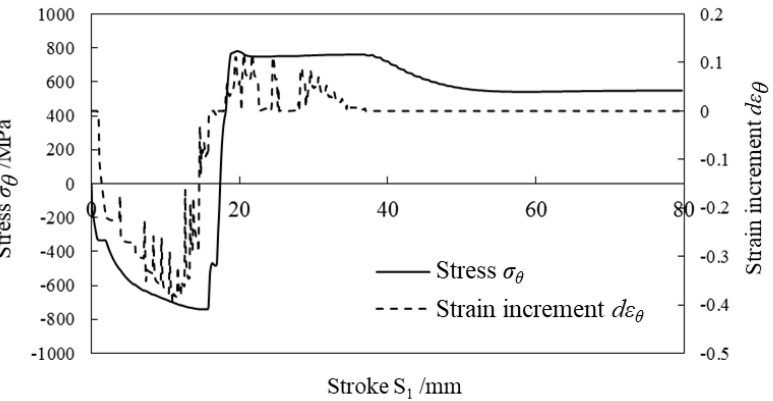
Figure 23. Change in Normal stress and strain rate along the θ direction to stroke in the first forward extrusion.